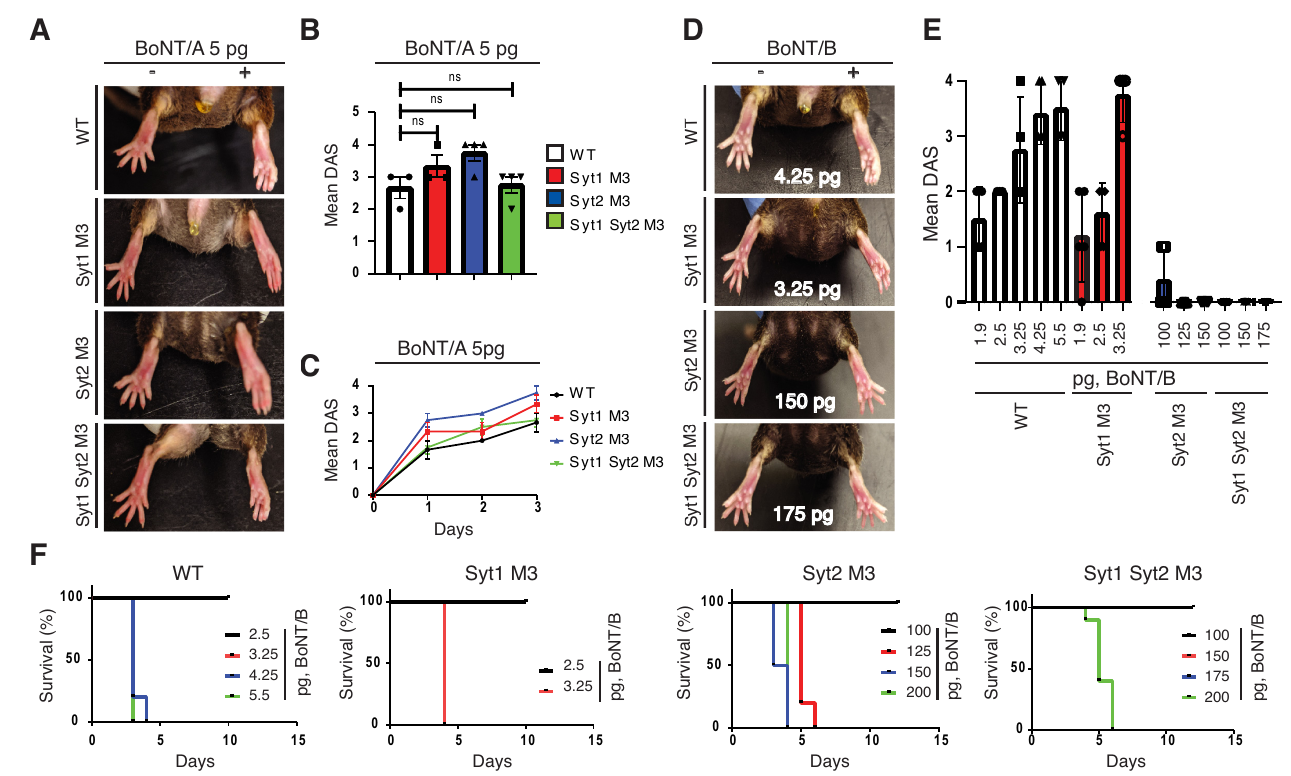
Fig 3. BoNT/B showed reduced potency and toxicity on Syt2 M3 KI mice. A-C. BoNT/A (5 pg) was injected into the right gastrocnemius muscle of mice and muscle paralysis was scored by monitoring the degree of toe spreading in startle responses (DAS assays). BoNT/A showed the same levels of potency in inducing local muscle paralysis in DAS assays in WT, Syt1 M3 , Syt2 M3 , and Syt1/Syt2 M3 double KI mice. Representative pictures of toe spreading are shown in A. The maximal DAS scores are plotted in B, and the mean daily DAS scores three days after toxin injection are plotted in C. Data represent mean +/- SEM. ns = not significant. D-F. BoNT/B showed reduced potency in inducing local paralysis and systemic toxicity in DAS assays on Syt2 M3 KI and Syt1/Syt2 M3 KI mice compared with WT and Syt1 M3 KI mice. Representative images of toe spreading in DAS assays with the indicated doses are shown in D, mean DAS scores with different toxin doses are plotted in E, and the survival rates with the indicated toxin doses are plotted in F. The BoNT/B doses that resulted in moribund start at 4.25 pg for WT, 3.25 pg for Syt1 M3 , 125 pg for Syt2 M3 , and 200 pg for Syt1/Syt2 M3 mice. Panels A, B, C–WT and Syt1 M3 mice, n = 3, Syt2 M3 and Syt1/Syt2 M3 mice, n = 4. Panels D, E–all groups that received BoNT/B injection, n = 5. Except for the following groups: WT 5.5 pg BoNT/B (n = 4); Syt2 M3 100 pg BoNT/B (n = 10); Syt2 M3 150 pg BoNT/B (n = 3); Syt1/Syt2 M3 100 pg BoNT/B (n = 6); Syt1/Syt2 M3 150 pg BoNT/B (n = 6). Panel F–these numbers are from the same dataset as panels D,